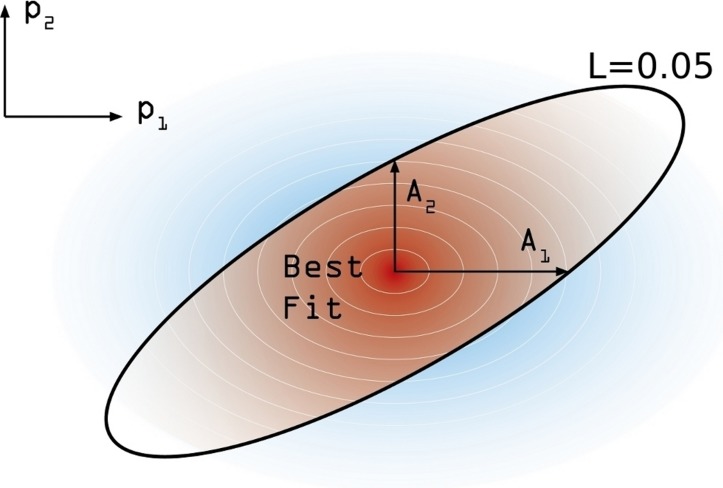
Confidence intervals estimation scheme.Degraded shades represent the joint probability density associated to the estimation of confidence intervals around the model best fit. The modulation coefficient c is determined so as to make the brown area within the black line of \documentclass[12pt]{minimal}
\usepackage{amsmath}
\usepackage{wasysym}
\usepackage{amsfonts}
\usepackage{amssymb}
\usepackage{amsbsy}
\usepackage{upgreek}
\usepackage{mathrsfs}
\setlength{\oddsidemargin}{-69pt}
\begin{document}
}{}$L(\vec{P})=0.05$\end{document}LP→=0.05 to precisely accumulate the 95% of the total joint probability distribution.